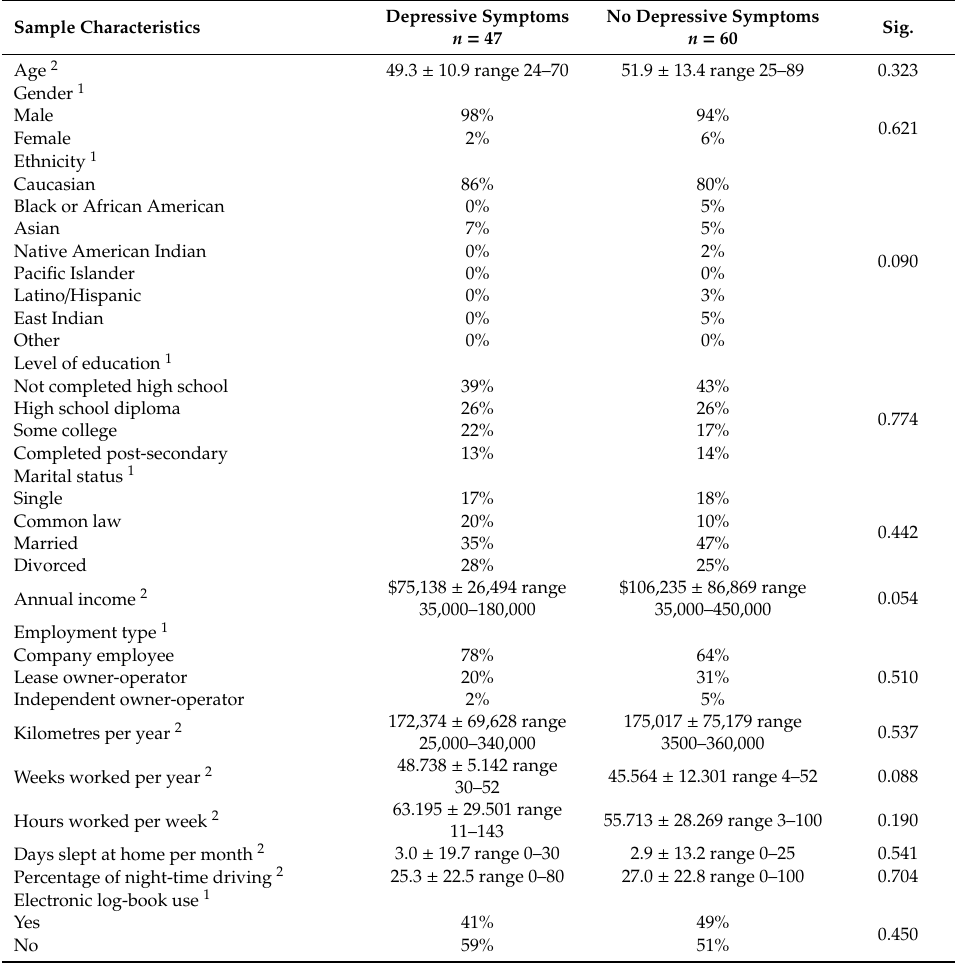
Table 1. Sample characteristics and comparisons by